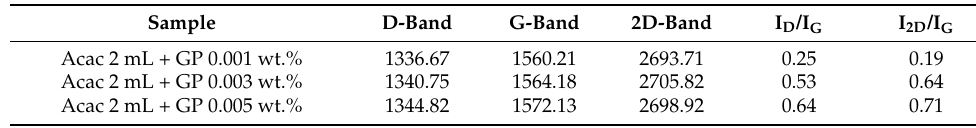
Figure 12. Raman spectra for the mixed Acac and GP with a TiO 2 mesoporous layer, corresponding to Figure 11. Table 3. The I D /I G ratio, I 2D /I G and the position of the D-band and G-peak for the mixed Acac and GP with a TiO 2 mesoporous layer.